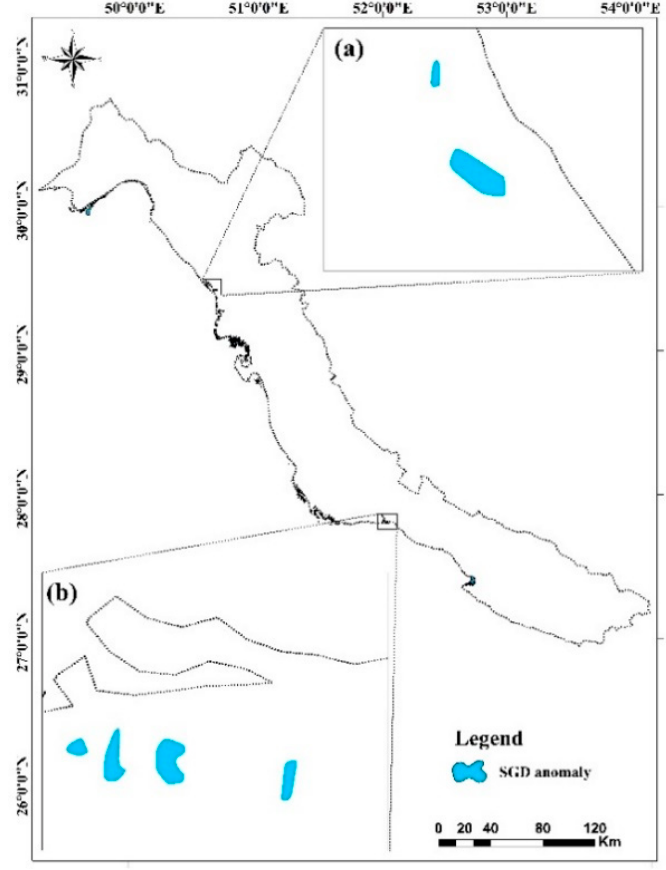
Figure 6. Geometric intersection of the anomalies based on all STA maps: ( a ) Shif-Hendijan and ( b ) Naiband #1. Table 1. The area of thermal anomalies in 2015 and 2016 and their overlapping surface area for each Row/Pass pair. (The Row refers to the latitudinal center line of a frame of imagery while the Path is a line that the satellite moves along it).